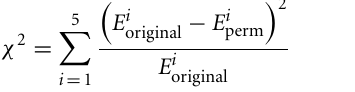
FIGURE 5 | A subset of electrode-pairs (left) showing significant ( p < 0 . 05) reduction in phase coherence extracted from the upper left corner plot of Figure 4 (referenced to Cz, in dark blue lines) and Koskinen et al. reported pattern (Koskinen et al., 2001) (right, referenced to FCz, in light blue lines) for the coherence measured from 9 electrodes: Nz (nasion), Fp1 (cid:4) (about 1 cm down from Fp1, just above the eyebrow), Fp2 (cid:4) , Fz, F7, F8, Cz, Pz, and